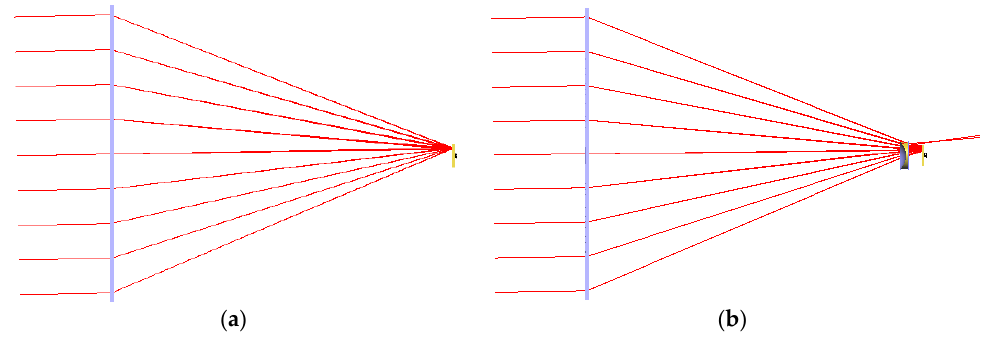
Figure 9. Ray ‐ tracing at incidence angle of 1.2°: ( a ) the conventional CPV unit; and ( b ) the proposed CPV unit.